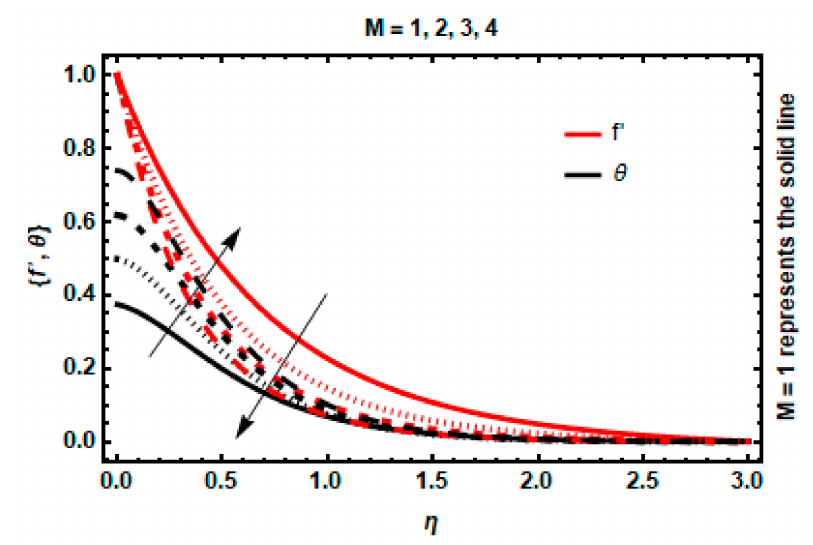
Figure 6. Impact of M on velocity and temperature.